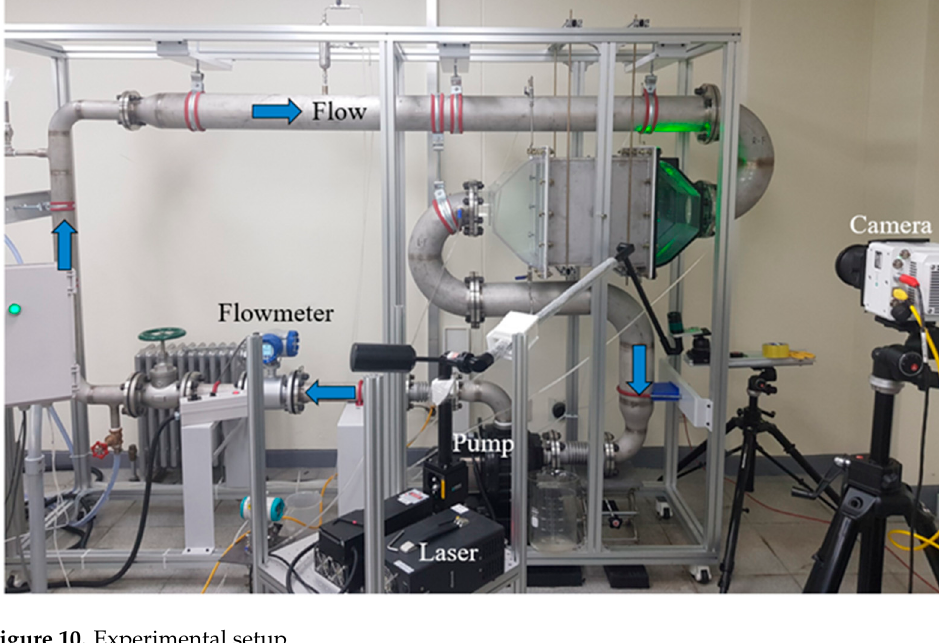
Figure 10. Experimental setup.